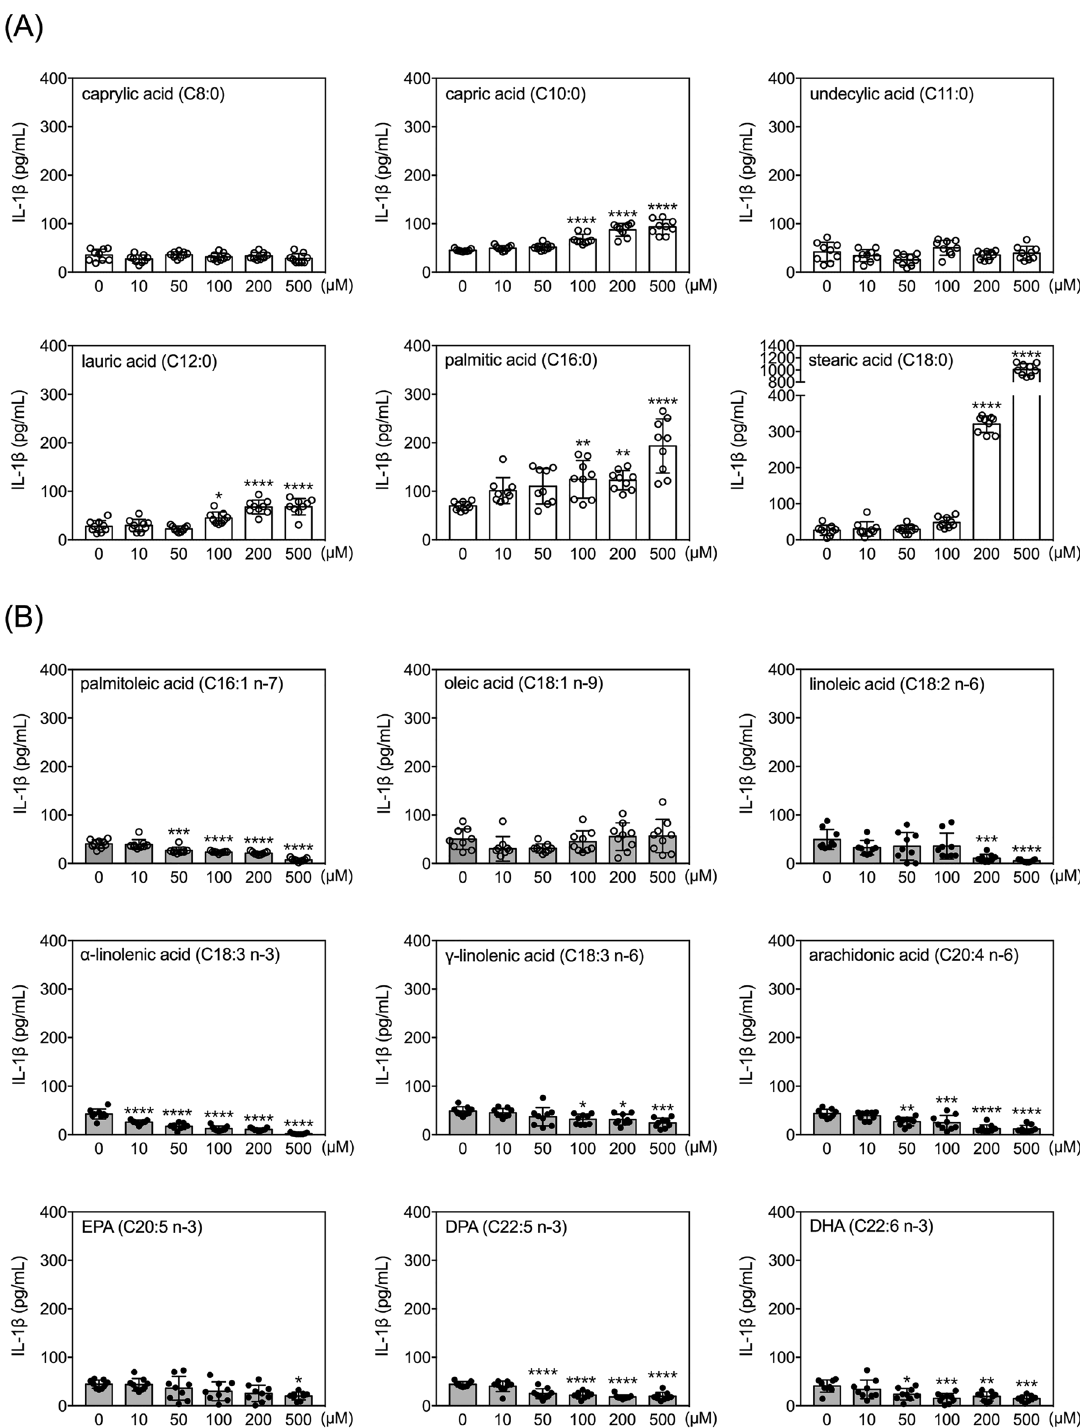
Figure 3. Effects of fatty acids on IL-1β secretion by human THP-1 monocytes. Quantitative results of levels of IL-1β in the conditioned media of THP-1 cells treated with selected FAs at different doses for 24 h. Data are presented as mean ± standard deviation. * p < 0.05, ** p < 0.01, *** p < 0.001, **** p < 0.0001, versus 0 µM vehicle group, Dunnett’s multiple comparisons after one-way ANOVAs. n =